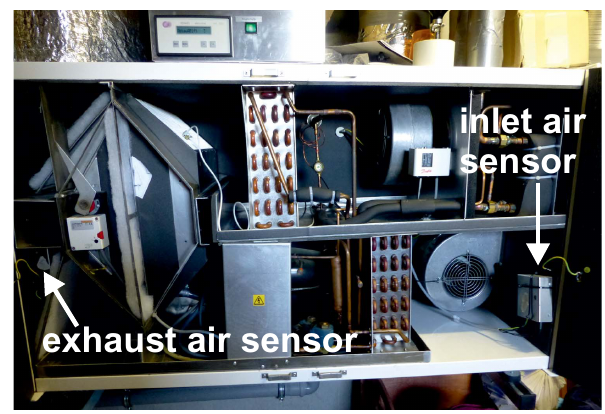
Figure 9. Position of the sensors in the ventilation system.